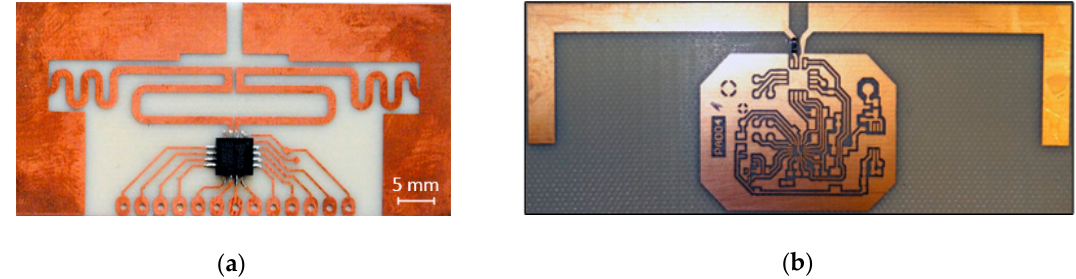
Figure 21. Test antennas of the UHF band: ( a ) Transponder designed to laboratory tests; ( b ) Transponder dedicated to work as the RFID sensor.